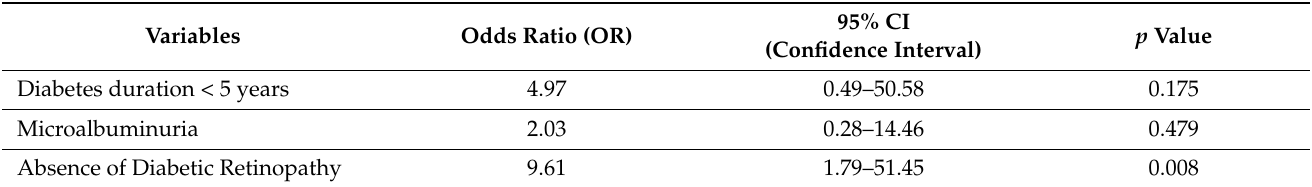
Table 5. Multinomial logistic regression shows the association between clinical indicators and non-diabetic kidney